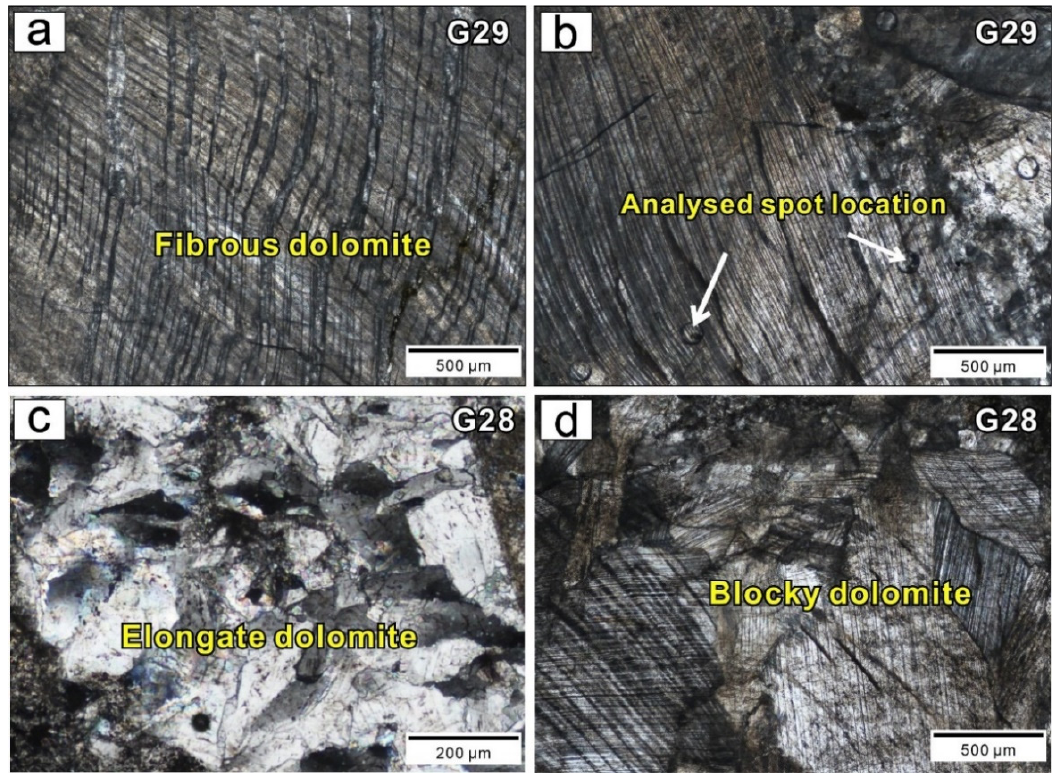
Figure 5. Micrographs of main features of syn-tectonic dolomite crystals. ( a ) fibrous dolomite crystal from dated samples G29 formed by crack-seal mechanism. ( b ) locations of U-Pb analyses. ( c , d ) Elongate and blocky crystals with north-west vein arrays from G28.